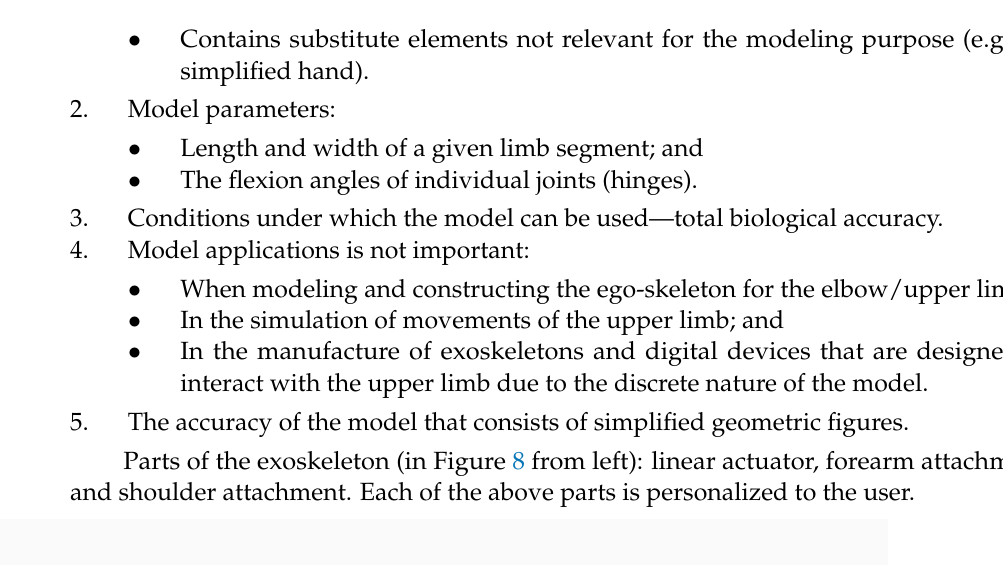
Figure 7. Exoskeleton project (1-Shoulder girdle; 2-scapular joint; z3-replacement arm; 4- elbow joint; z5-replacement forearm; 6 wrist joint; z7-replacement hand).